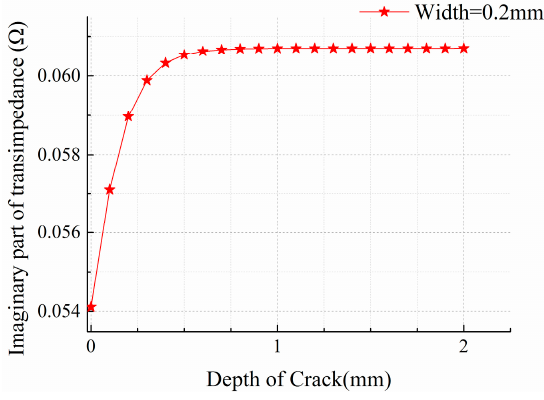
Figure 5. Sensor response of cracks with different depth.